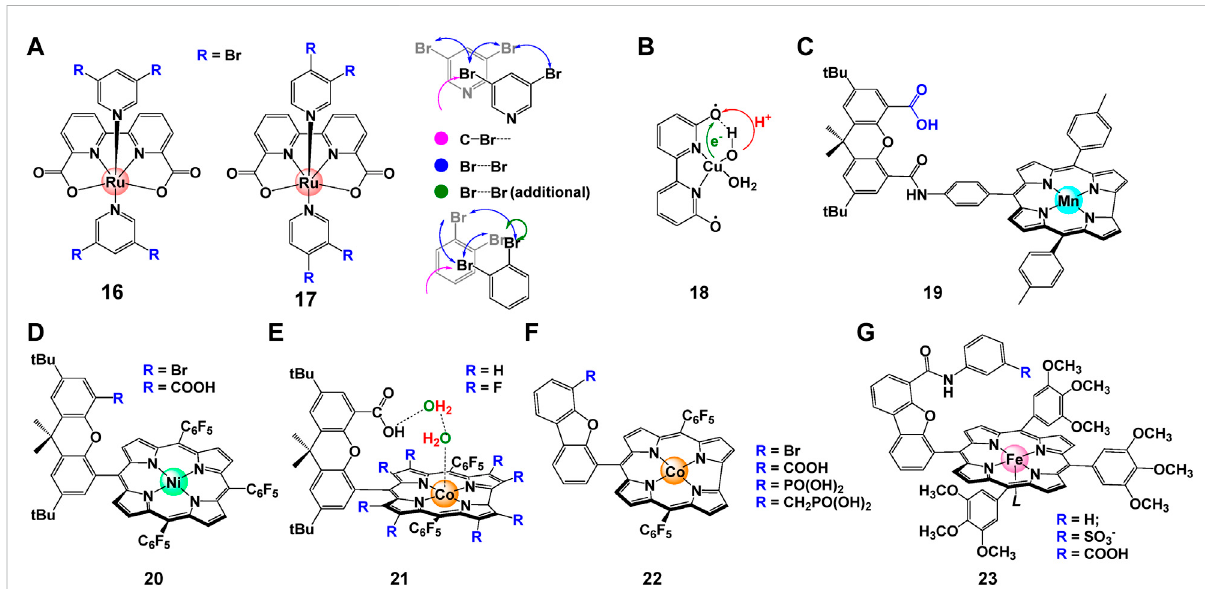
FIGURE 7 (A) The chemical structures of complex 16 and 17 , and the off-set interactions involved in Ru-bda catalyst, adapt with permission from Angew. Chem. Int. Ed. 2021, 60, 14504 – 14511. Copyright 2021 Angewandte Chemie International Edition published by Wiley-VCHGmbH. (B – G) Chemical structure of (B) copper complex 18 [Cu(bpy)(OH) 2 ](Zhang et al., 2014), (C) Mn corrole complexes 19 (Gao et al., 2007), (D) nickel hangman complex 20 (Bediako et al., 2014), (E) cobalt hangman complex 21 (Dogutan et al., 2011; Neuman et al., 2020; Zhang et al., 2021), (F) cobalt